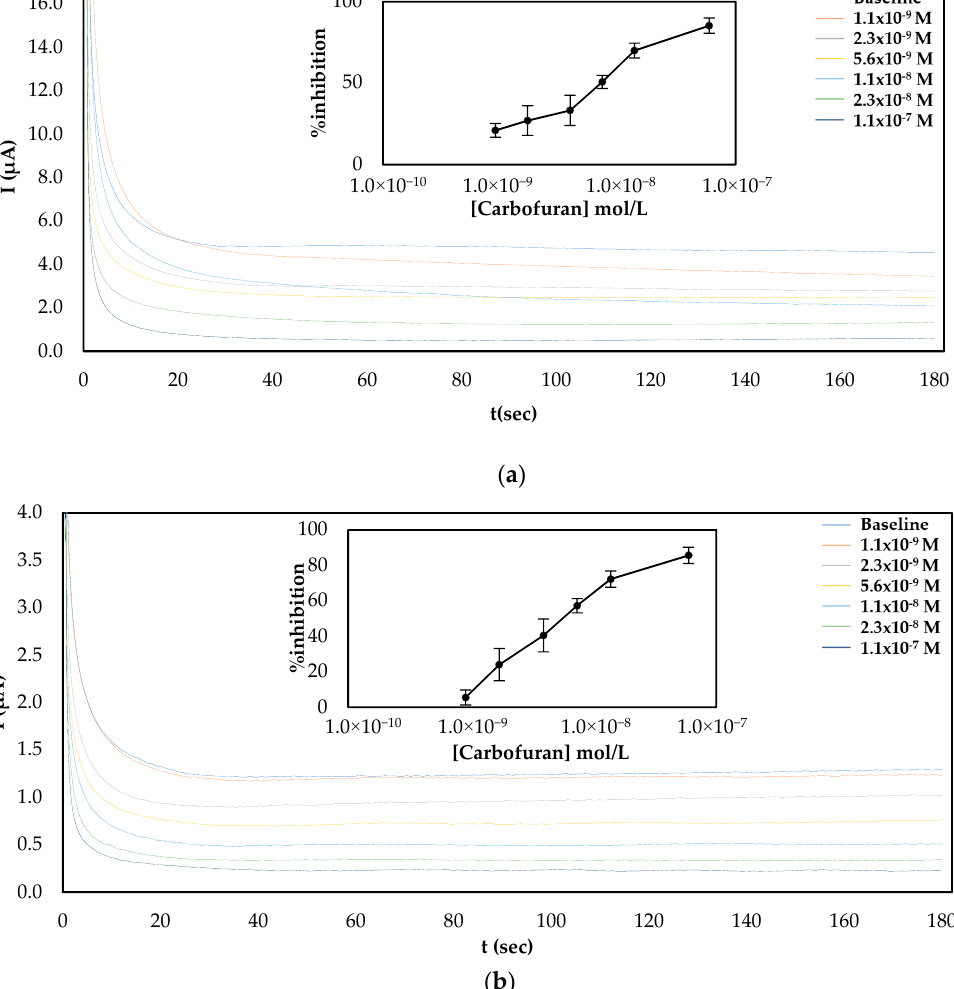
Figure 4. Characteristic amperograms of current recorded over time for the uninhibited enzyme (baseline) and following incubation with increasing concentrations of carbofuran in standard samples for CB/CS/AChE-modified electrodes fabricated following the ( a ) multistep and ( b ) one-step approaches at a constant applied potential of +250 mV. The graphs shown in the insets show the mean percentage inhibitions (% inhibitions) of different concentrations of carbofuran obtained from 5 different electrodes.